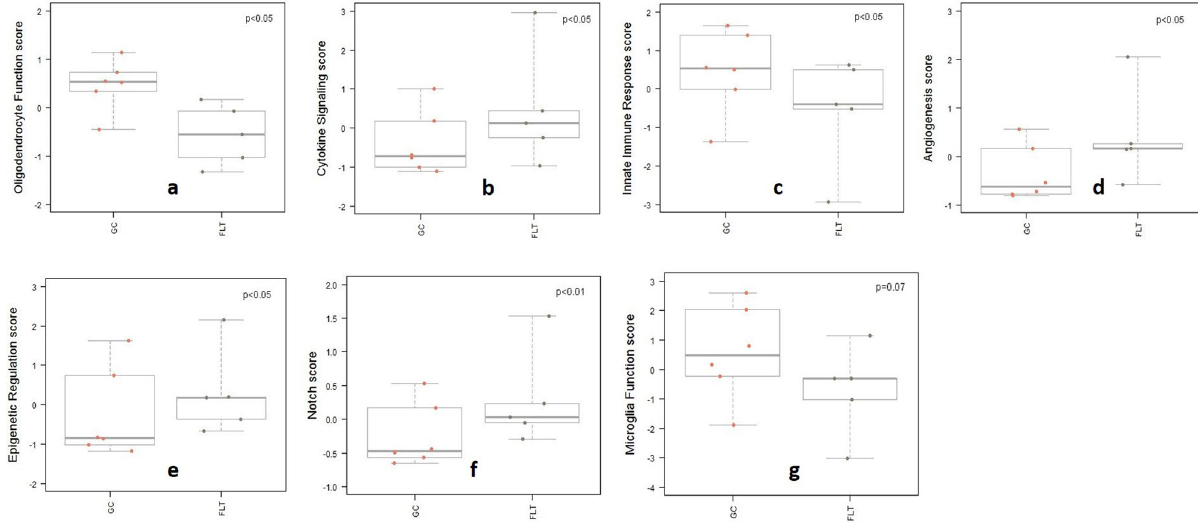
Fig. 6 Space fl ight-induced changes in nueroin fl ammation pathway scores among fl ight (FLT) and ground controls (GC) groups. Boxplots depict pathway scores on the y -axis and the experimental conditions on the x -axis. N = 5 – 6 /group. p values are calculated using one-way analysis of variance (ANOVA) and Tukey ’ s HSD (honestly signi fi cant difference) test. a Oligodendrocyte function score p < 0.05, b cytokine signaling score p < 0.05, c innate immune response score p < 0.05, d angiogenesis score p < 0.05, e epigenetic regulation score p < 0.05, f notch score p < 0.01, and g Microglia function score p = 0.07. Boxes are the range between fi rst (25%) and the third (75%) quartile, the center line is the median, the whiskers include the variability those quartiles. Source data are provided as a Source Data fi